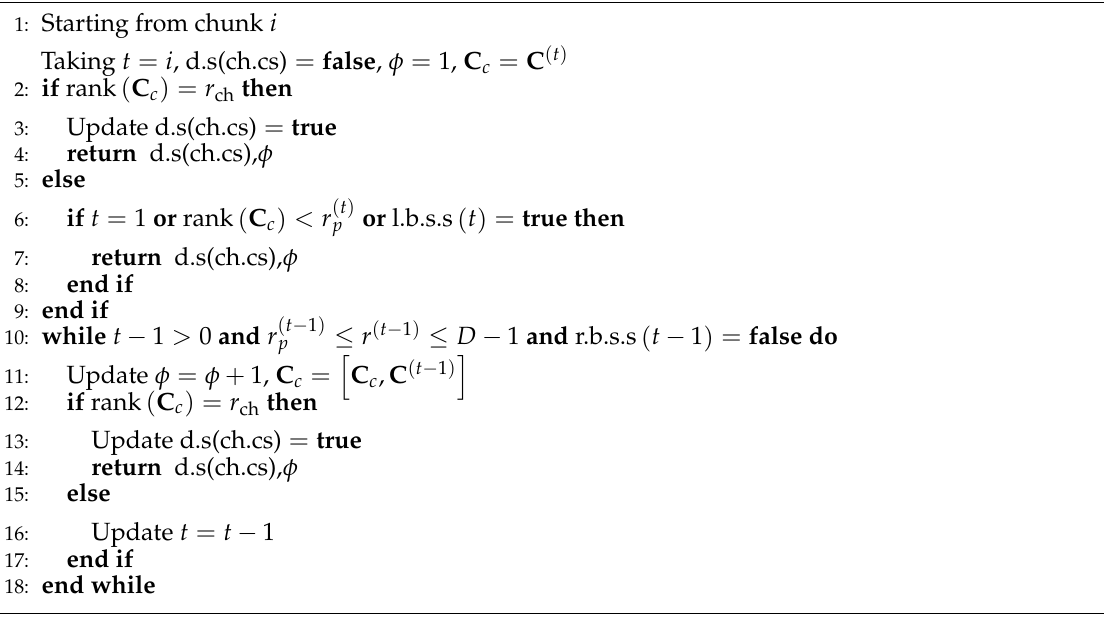
Algorithm 3 Combination of chunks.